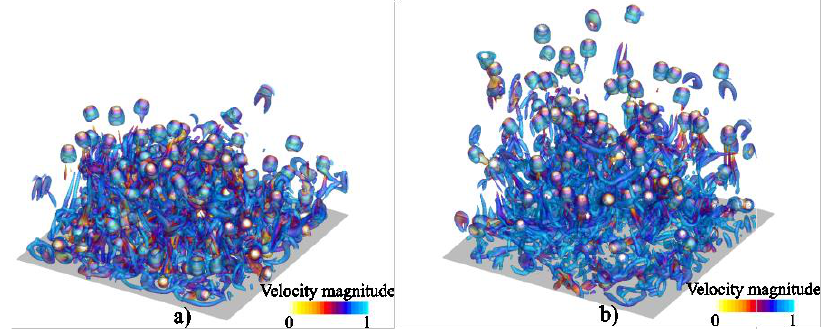
Figure 20. Instantaneous distribution of second invariant of velocity tensors ( Q = 0.1) for scheme B200: ( a ) t * = 40, ( b ) t * = 50. The color of the isosurface represents the magnitude of the velocity.